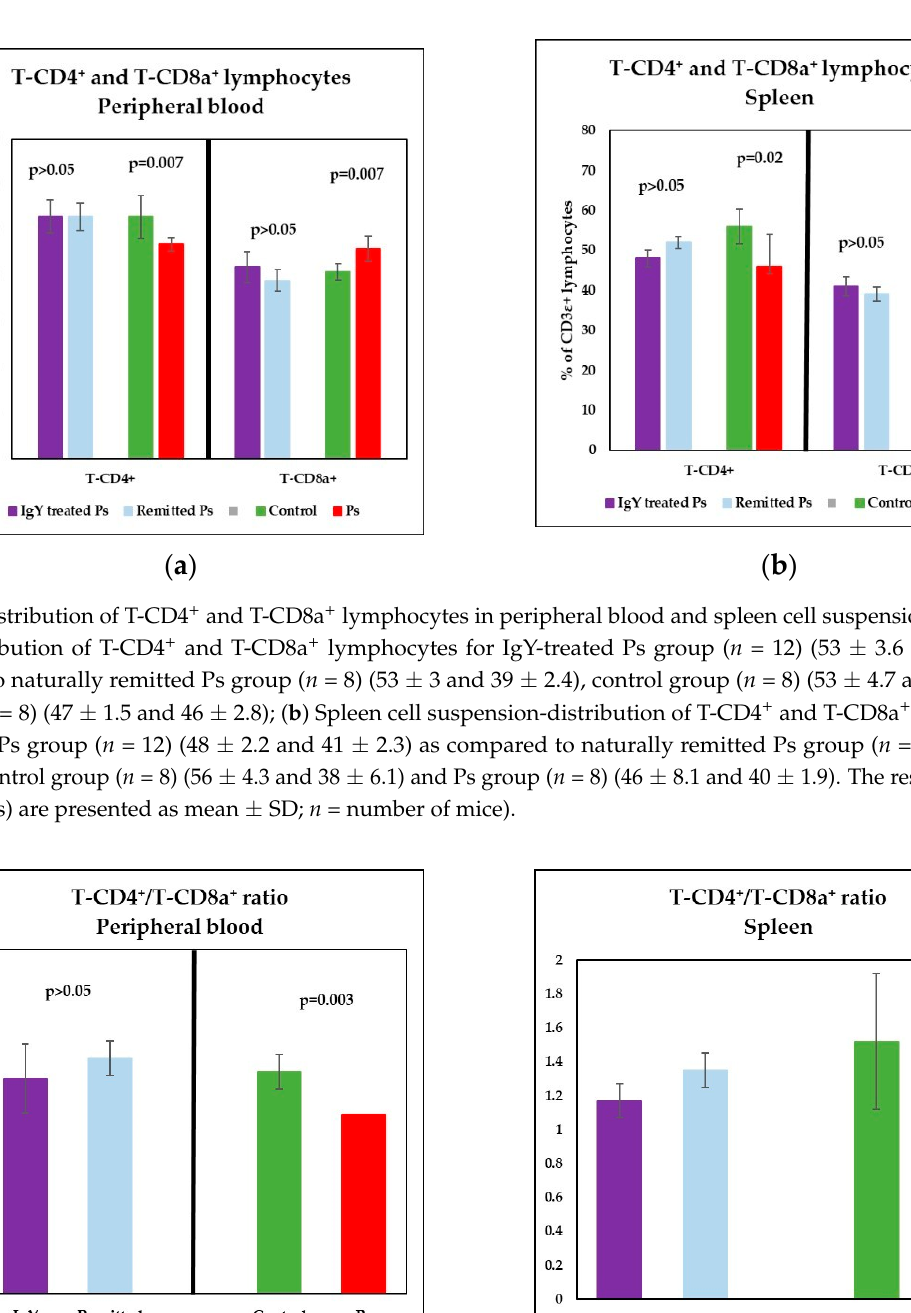
( b ) Figure 6. Distribution of B - CD19 + and NK1.1 + cells in peripheral blood and spleen cell suspension. ( a ) Peripheral blood- distribution of B - CD19 + and NK1.1 + cells for IgY-treated Ps group (n = 12) (83 ± 3.2 and 4 ± 0.7) as compared to naturally remitted Ps group (n = 8) (77 ± 5.5 and 5 ± 1.1), control group (n = 8) (85 ± 5.3 and 4 ± 0.7) and Ps group (n = 8) (31 ± 12.8 and 12 ± 3.3); ( b ) Spleen cell suspension–distribution of B - CD19 + and NK1.1 + cells for IgY - treated Ps group (80 ± 1 and 3